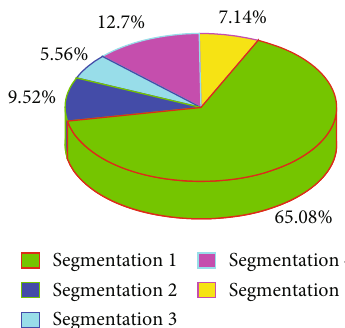
Figure 3: Fan-shaped distribution diagram of the false detection rate of interior design e ff ect image detection after model segmentation.